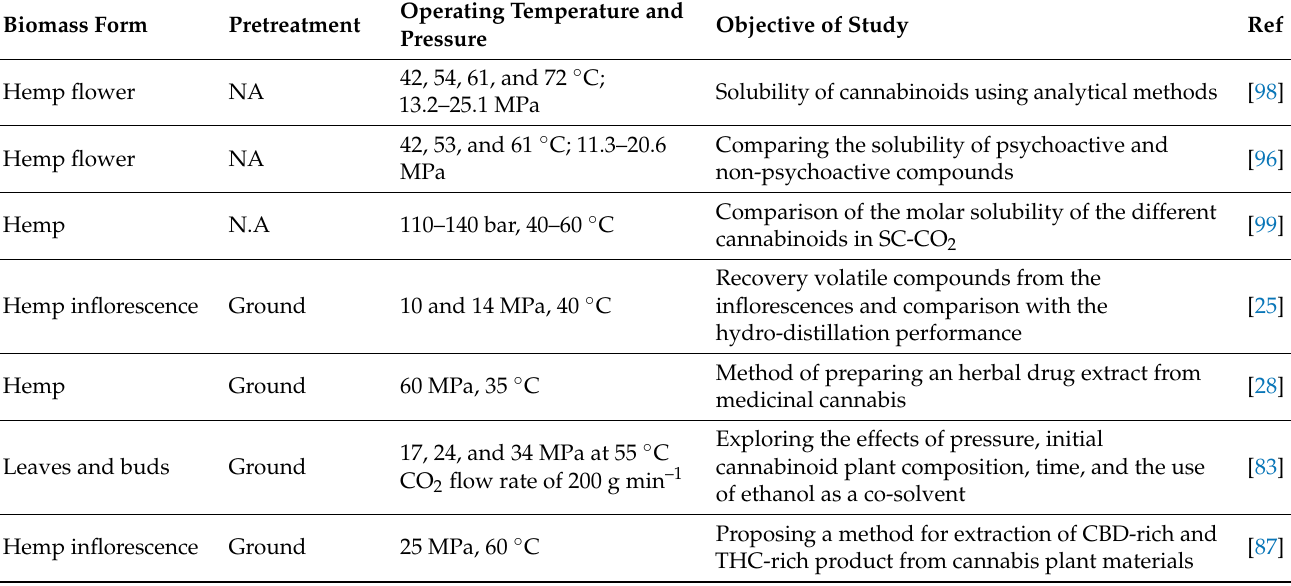
Table 5. Published studies about cannabinoid extraction using SC-CO 2